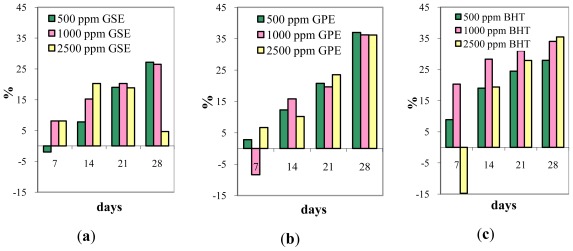
The decline registered in OTA content on treatment with natural extracts (a) GSE; (b) GPE; (c) BHT.